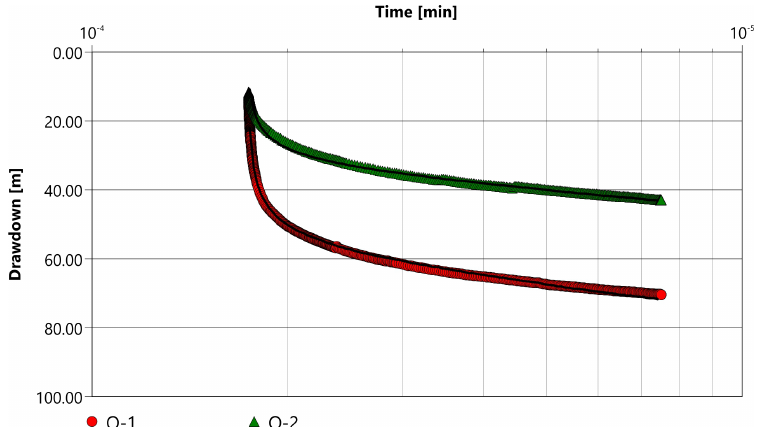
Figure 9. Analytical diagram for measurements in O-1 and O-2 during the second steps of the pumping test (Theis method).